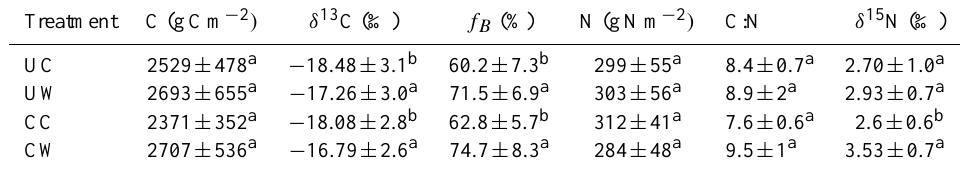
Table 3. Soil organic C and N content, 13 C- and 15 N signature, fraction of C 4 -derived C ( f B ) , and the C:N ratio of whole soils in a tallgrass prairie (0–20cm depth) after nine years of warming and clipping. Data are expressed as mean ± SE, n = 6. Different letters indicate statistical significance at P < 0 . 05 among the four treatments. Abbreviations: UC, unclipped control; CC, clipped control; UW, unclipped warming; CW, clipped warming.